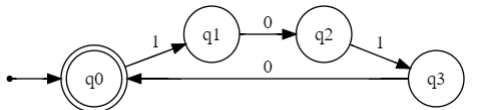
Figure 2. DFA recognizing a sublanguage of Tomita’s 5th grammar.